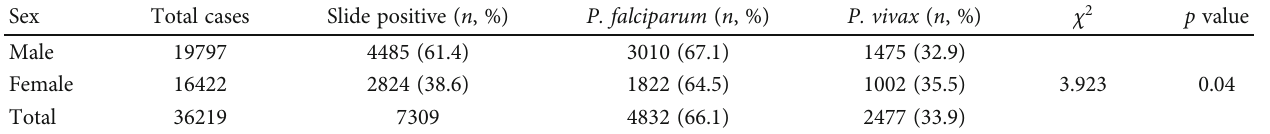
Table 2: Distribution of con fi rmed malaria cases by sex at MHC, from 2015-2019.